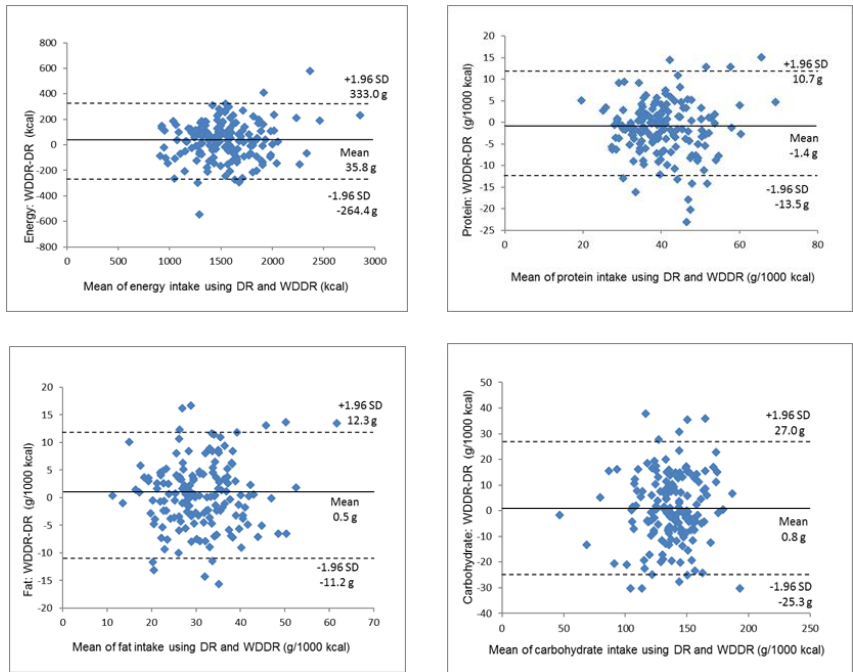
Figure 4. Bland–Altman plots for agreement between energy and energy-adjusted intakes of nutrients (protein, fat and carbohydrates) using the DR and WDDR for 163 women for 1 day. DR: dietary record; WDDR: website dish-based dietary record; SD: standard deviation. Nutrients 2017 , 9 , 1058